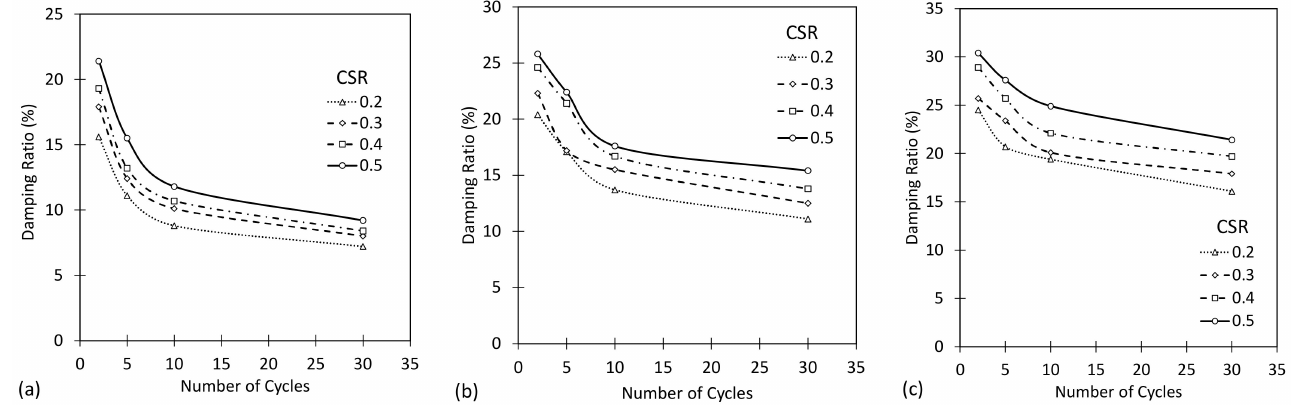
Figure 9. Effects of increasing number of loading cycles on the damping ratio for different CSR conditions and vertical stresses of ( a ) 50 kPa, ( b ) 150 kPa and ( c ) 250 kPa for the second reconstruction.